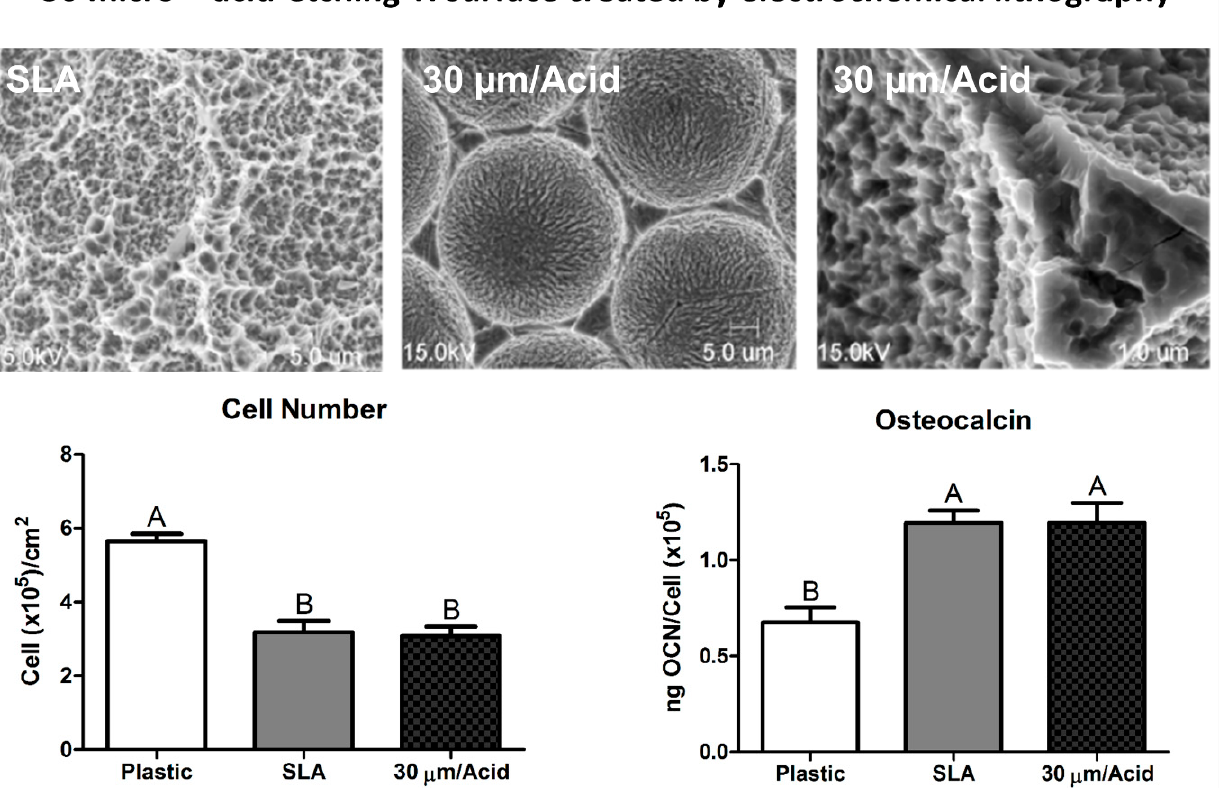
Figure 1. Osteoprogenitor cells differentiate in response to discrete surface topography that mimics the physical parameters of a bone surface modified by a bone resorbing osteoclast [30]. Clinically relevant implant surfaces were produced by grit blasting with large grit corundum and subsequently acid etching in the same manner. Osteoprogenitor cells cultured on both these modified titanium substrates exhibited increased osteoblastic differentiation, as seen by decreased proliferation and increases in osteoblastic markers such as osteocalcin, compared to cells cultured on tissue culture plastic. Groups not sharing letters are significant at a p -value of <0.05.